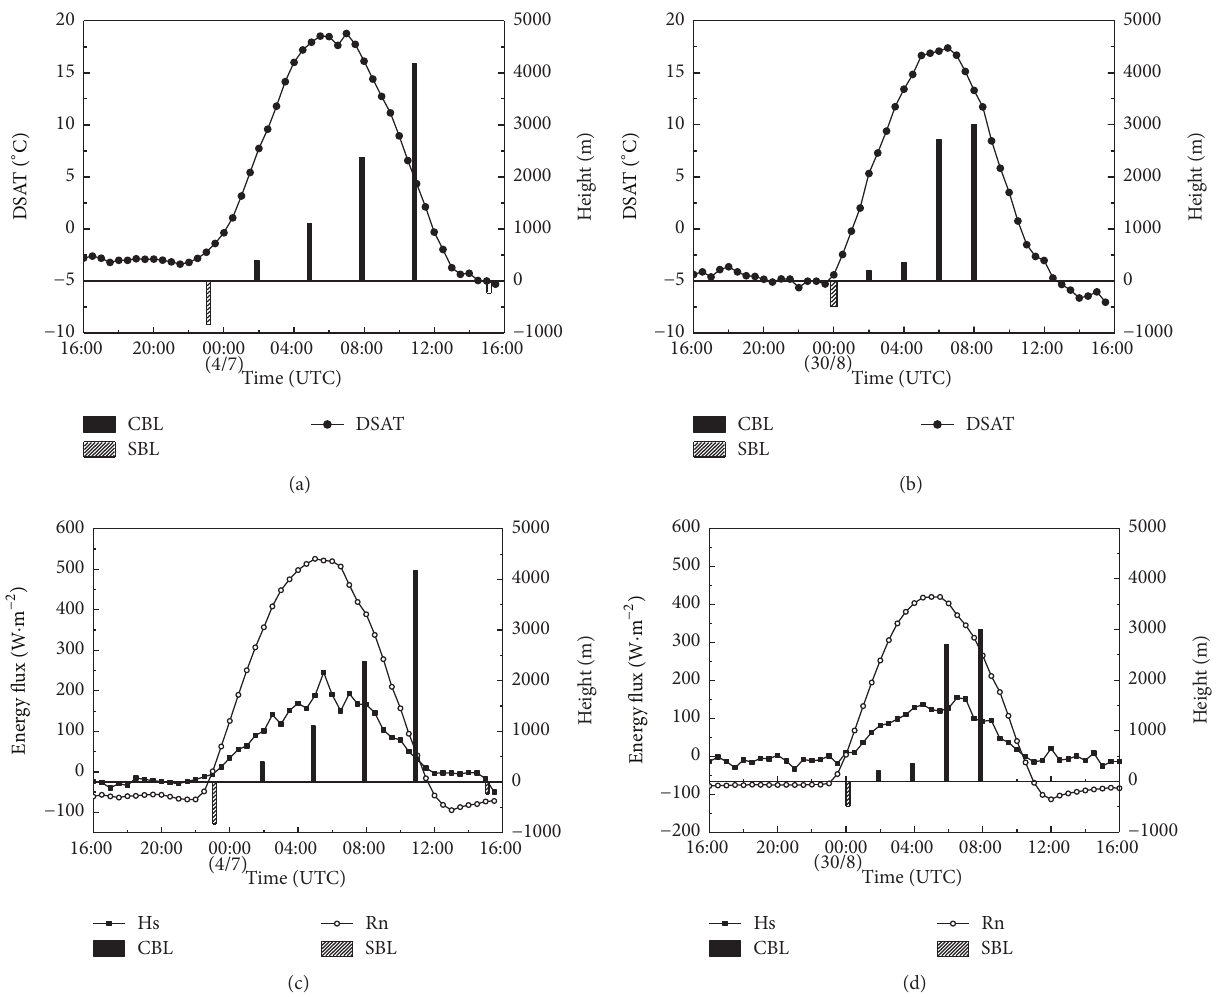
Figure 6: The daily relationship between DSAT, net radiation, sensible heat flux, and ABL on ((a), (c)) July 4, 2012, and ((b), (d)) August 30,